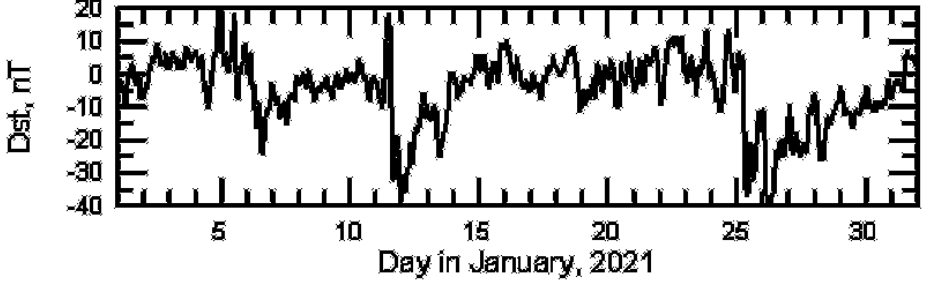
Fig. 4. Dynamics of the geomagnetic activity index Dst in January 2021 Small negative variations are associated with recurrent magnetic